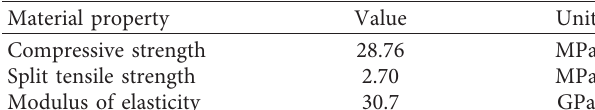
Table 6: Mechanical properties of SCRC.